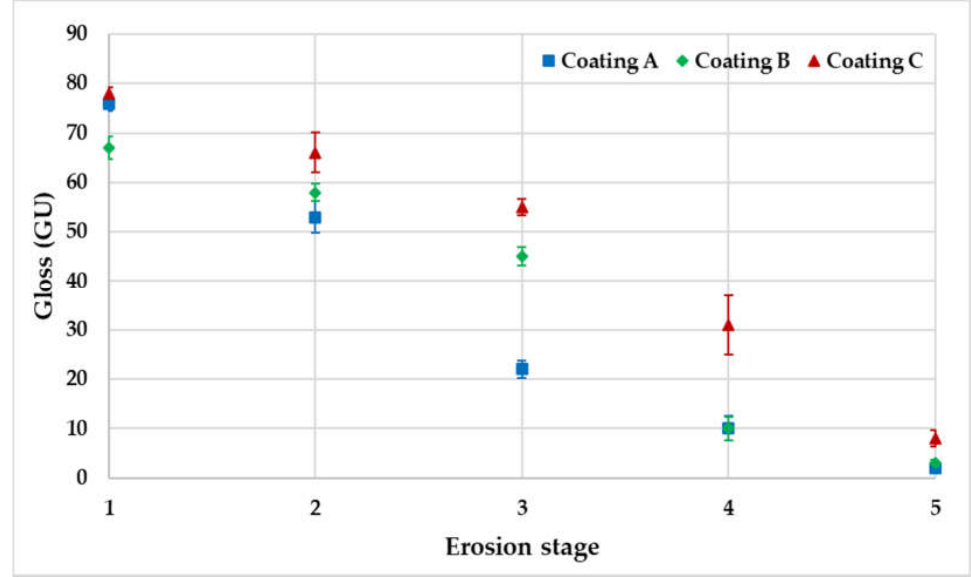
Figure 12. Coating surface gloss at each erosion stage for coatings A, B, and C.